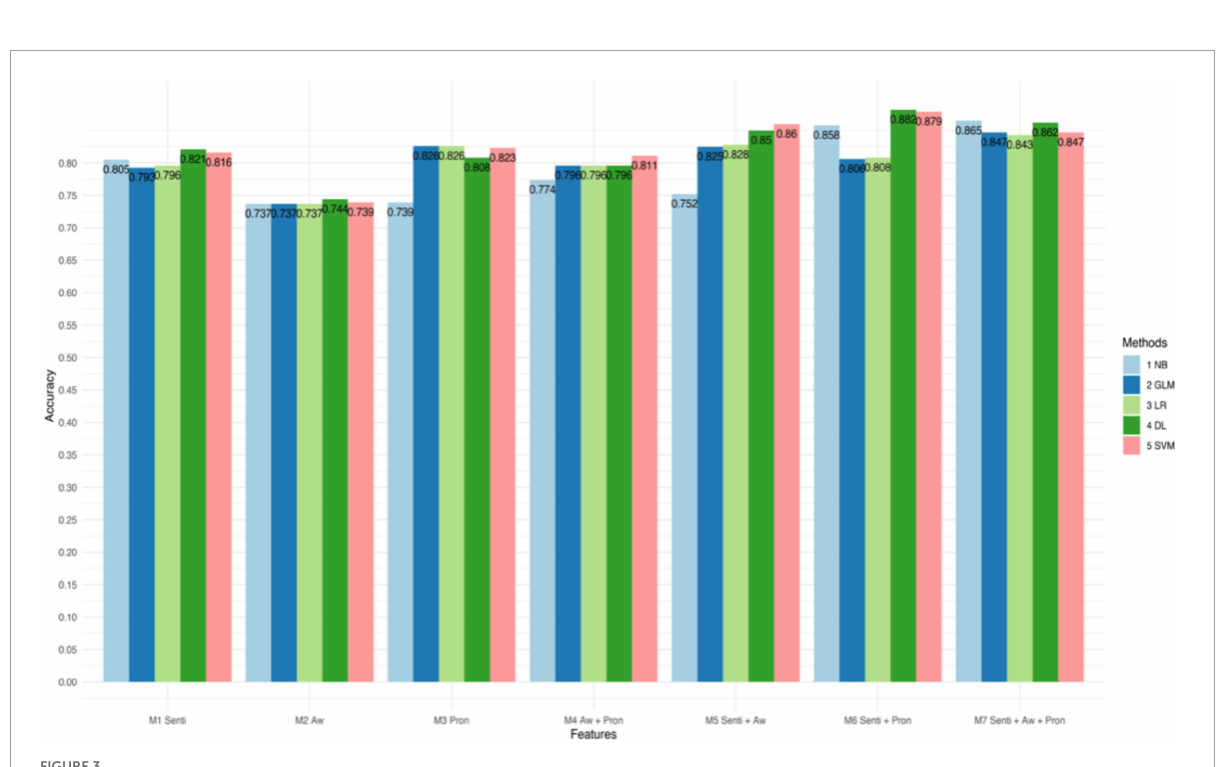
FIGURE3 Accuracy of different models in classifying texts of suicide